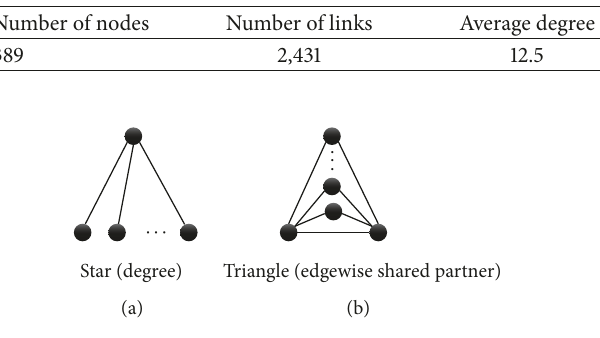
Figure 3: Two network configurations of coconsideration